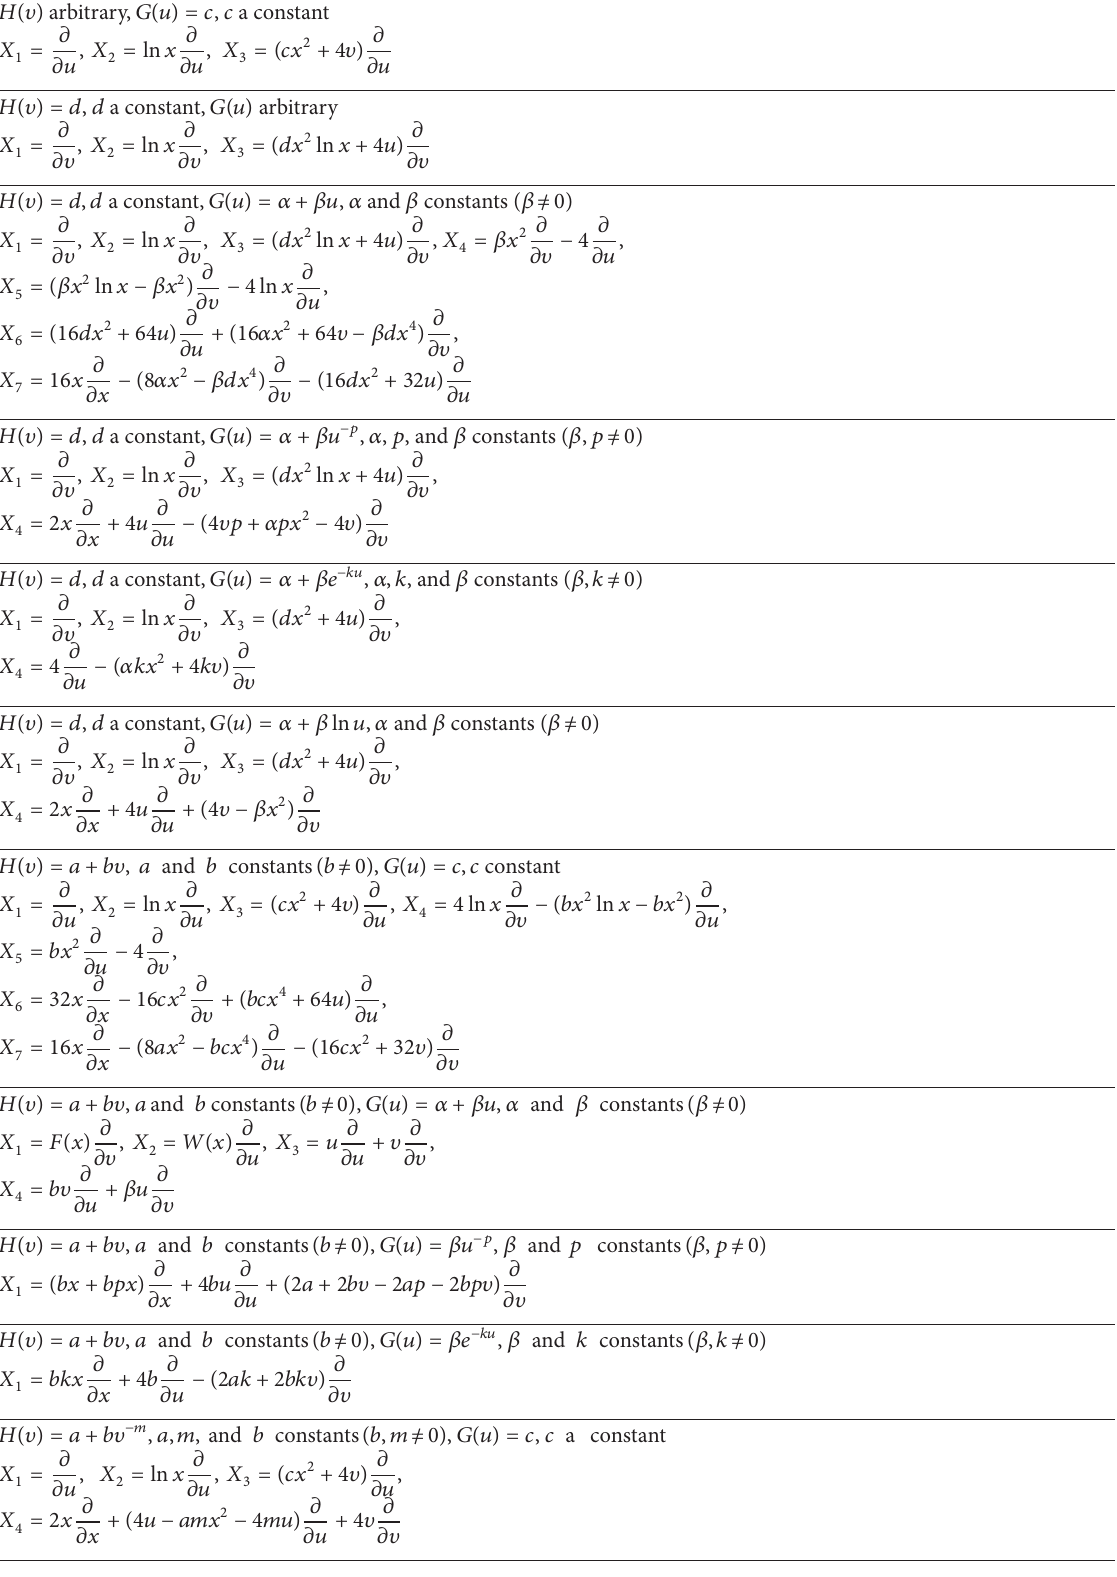
Table 3: Lie symmetries for 𝑛 = 1 , for various functions 𝐻(𝑣) and 𝐺(𝑢) . 𝐻(𝑣) arbitrary, 𝐺(𝑢) = 𝑐 , 𝑐 a